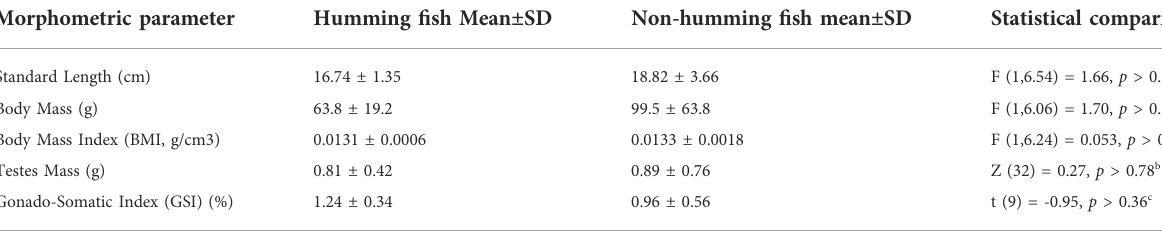
TABLE 1 Humming ( N = 5) and non-humming ( N = 6) fi sh did not differ in size, body condition, or gonad size.